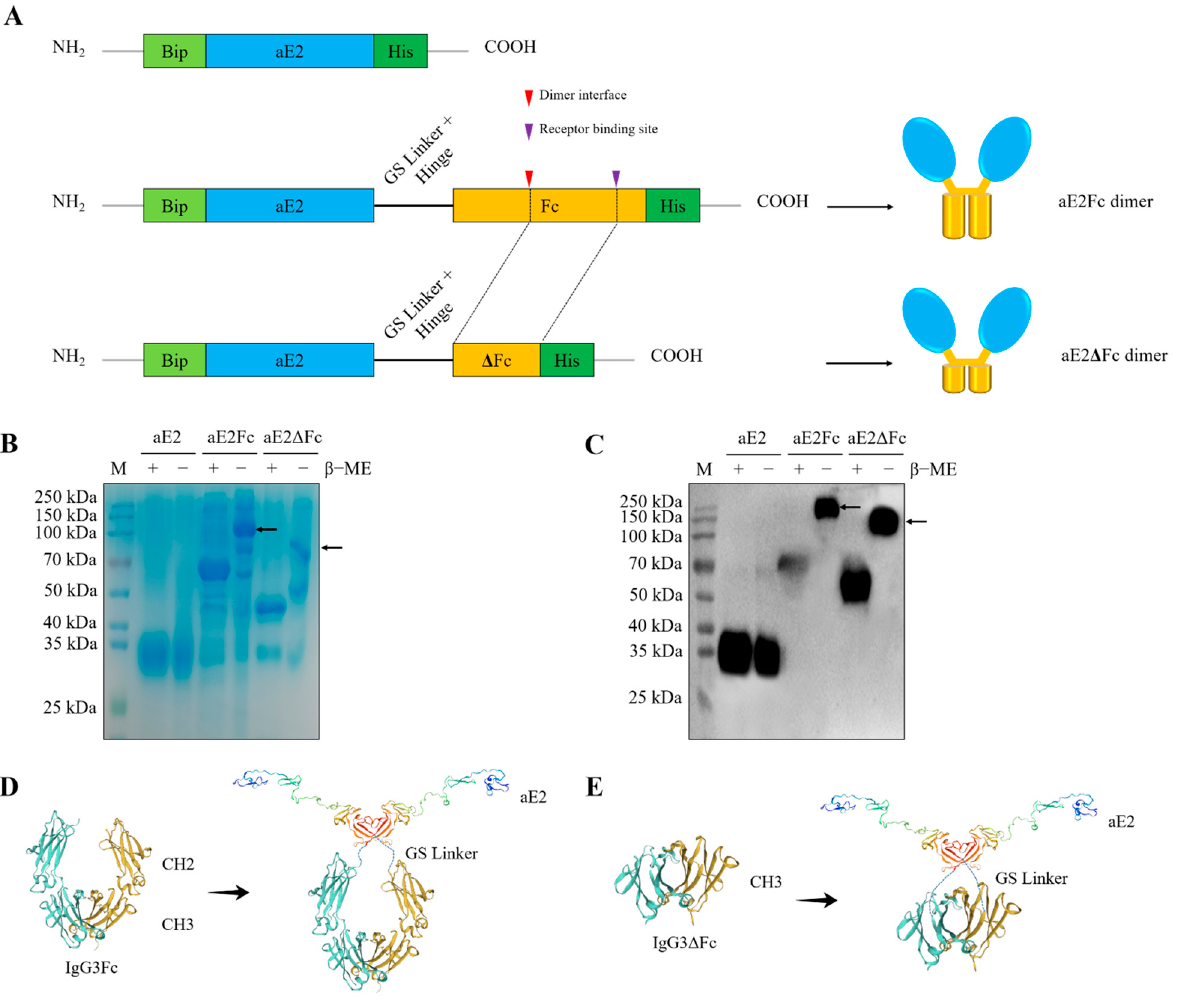
Figure 3. Characterization of APPV E2, E2Fc, and E2 ∆ Fc fusion proteins. ( A ) Schematic design of APPV E2, E2Fc, and E2 ∆ Fc proteins. APPV E2, E2Fc, and E2 ∆ Fc recombinant proteins were analyzed via SDS-PAGE ( B ) and western blotting with a monoclonal antibody against APPV E2 ( C ) in the presence (+) or absence ( − ) of the reducing agent β -mercaptoethanol. M, Marker; β -ME, β -mercaptoethanol. The black arrow indicates the bands of the Fc or ∆ Fc stabilized dimer. Structures of APPV E2Fc ( D ) and E2 ∆ Fc ( E ) proteins. The models were built using the SWISS-MODEL server (https://swissmodel.expasy.org/interactive, accessed on 2 June 2021), with SMTL ID: 2yq2.1.A (aE2), 5w38.1.A (IgG3Fc), and 5hsf.1.A (IgG3 ∆ Fc) used as the